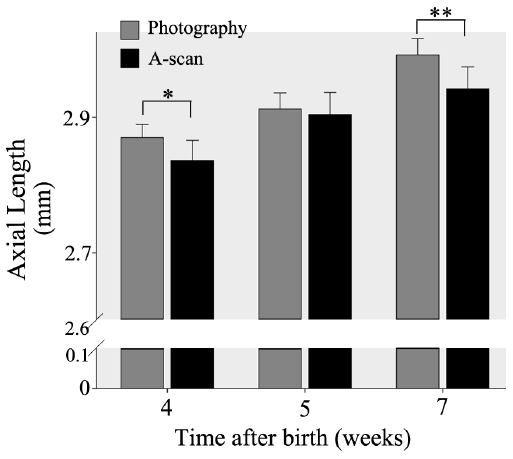
Figure 1. Comparison of axial length measurements by A-scan ultrasonography and by photographic imaging in control mice. The axial length measured by A-scan was less than that by photography, at 1 and 4 weeks of age. Six mice (12 eyes) were measured at each age. Data are presented as mean 6 SEM. (* P , 0.05 and ** P , 0.01).